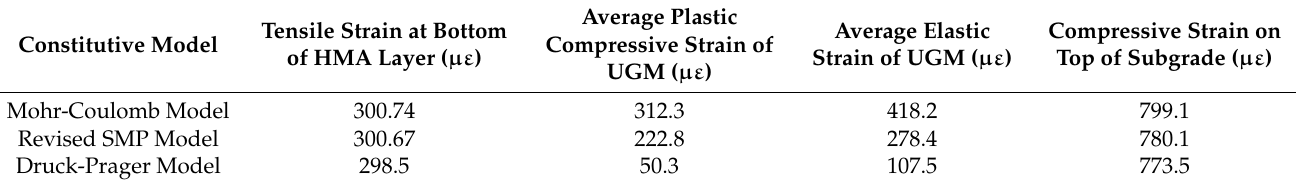
Table 4. Strains in different structure layers using the three